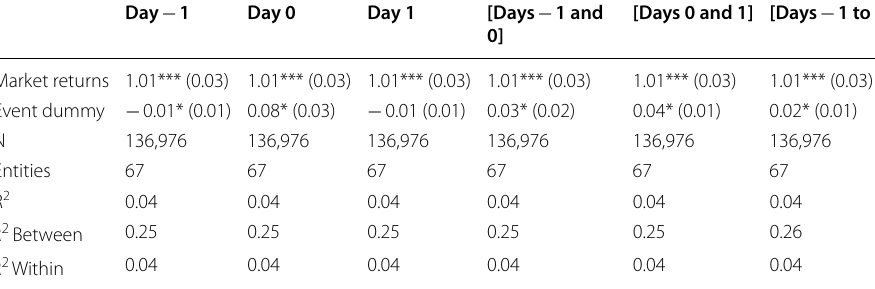
Table 6 Results of regression models with event